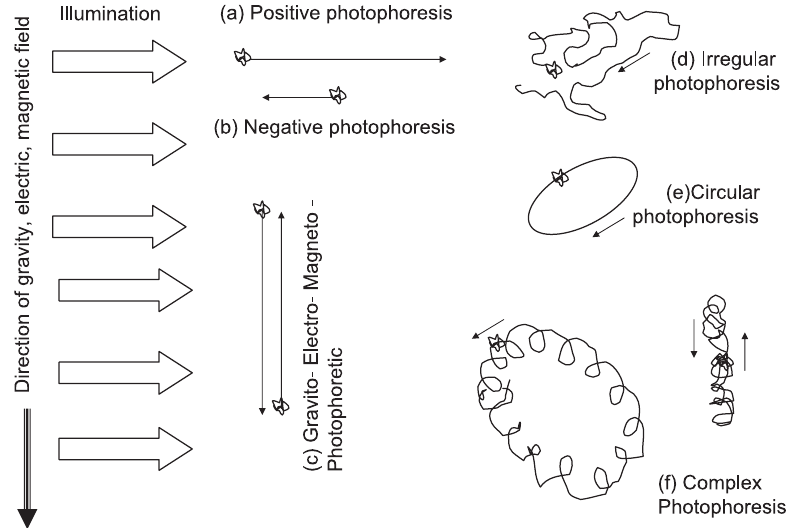
Fig. 1 Types of photophoresis. When illuminated, particles can move in or opposite to the direction of light ( a , b ), move in the direction of external fields ( c ), move similar to Brownian motion but more vigorously ( d ), move in closed loops ( e ) or perform complex motions.